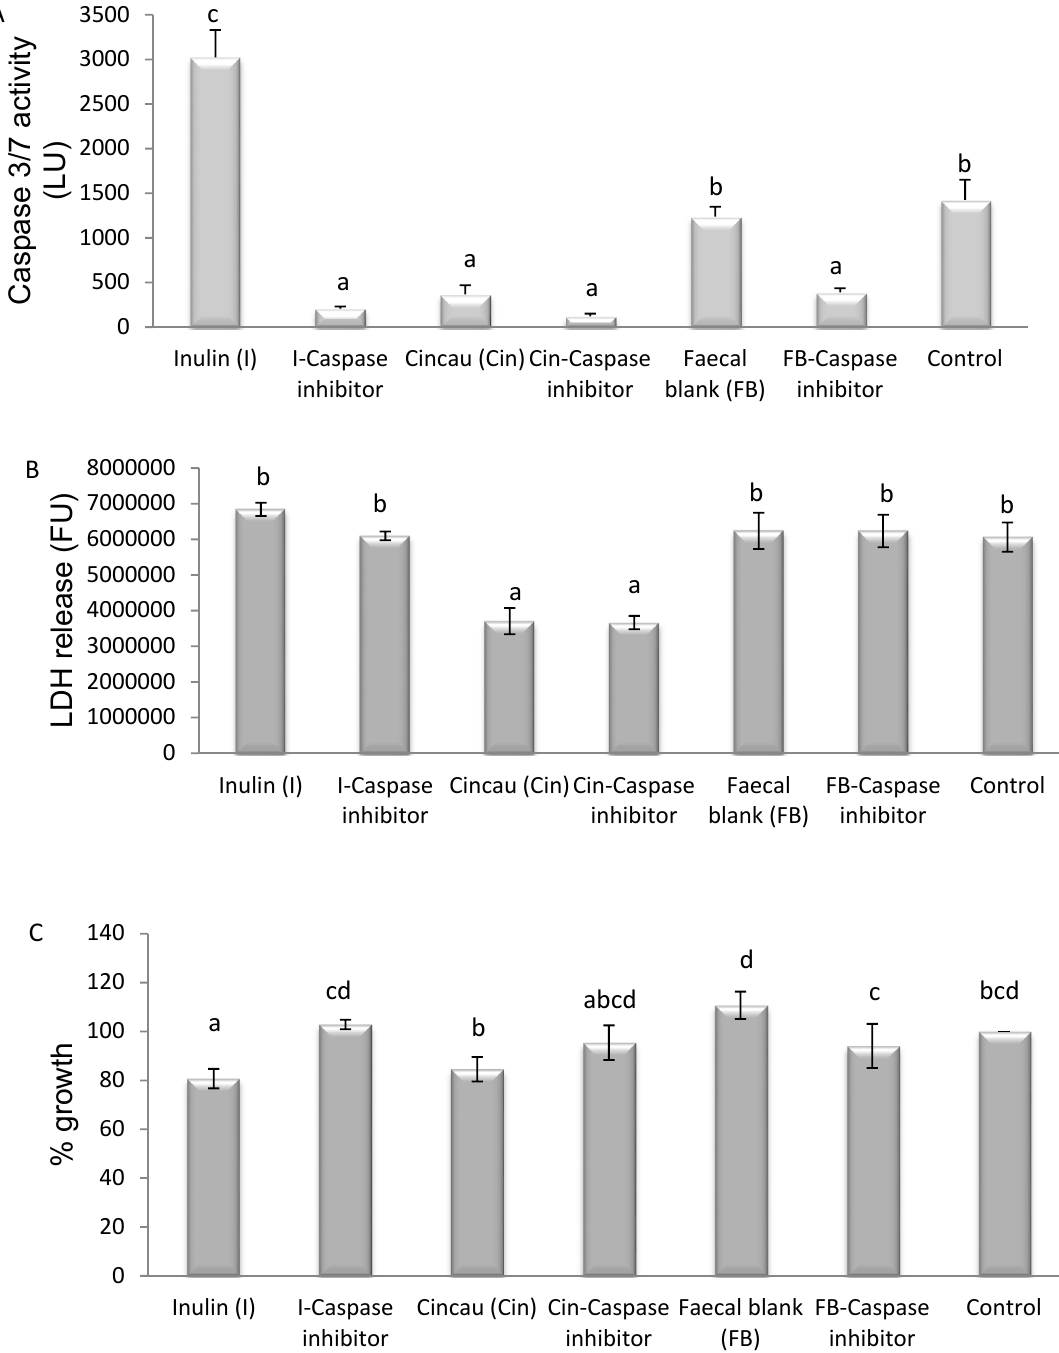
Figure 5. Effect of inulin and cincau on caspase 3/7 activity ( A ), LDH release ( B ), and Caco-2 cell viability ( C ) with or without caspase inhibitor. Cells were seeded 1 day before the treatment with FS (day 0), then incubated for 48 h in media containing 20% FS. Caspase inhibitor (10 µM) was added 1